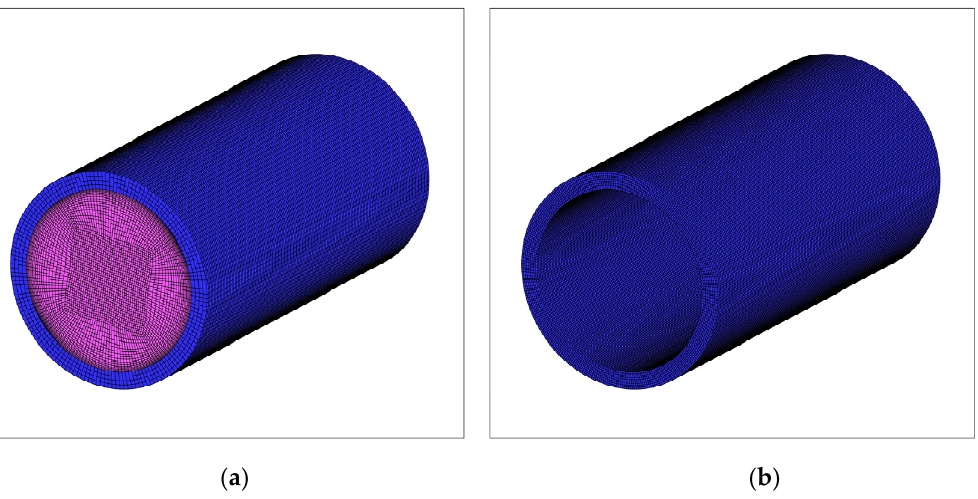
Figure 2. Computation meshes for the numerical procedure. ( a ) Meshes for temperature analysis. ( b ) Meshes for thermal stress analysis.